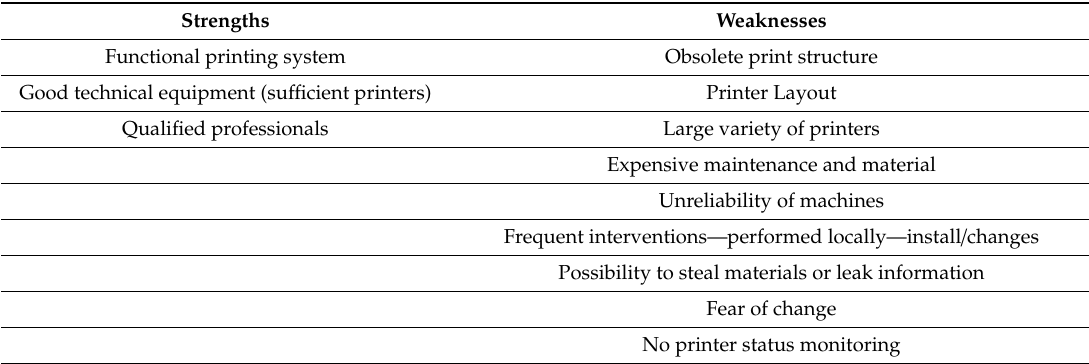
Table 3. Defining strengths and